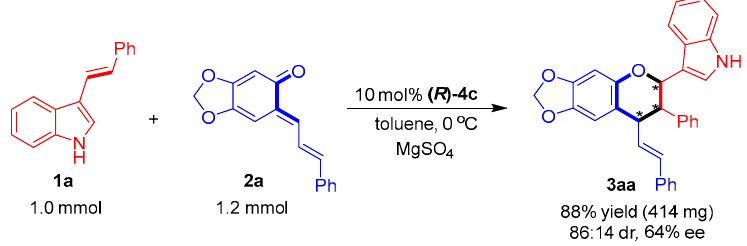
Figure 7. One-mmol-scale synthesis of product 3aa . The asterisk * indicates chiral center.